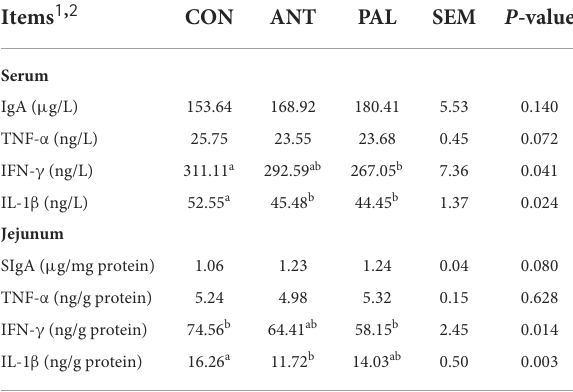
TABLE 4 Effects of dietary palygorskite supplementation on the immune function in broilers.